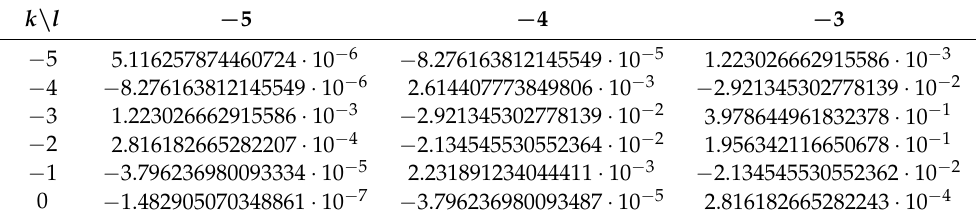
; [ 0,1 ]) evaluated up to machine precision. ( 2,1 )